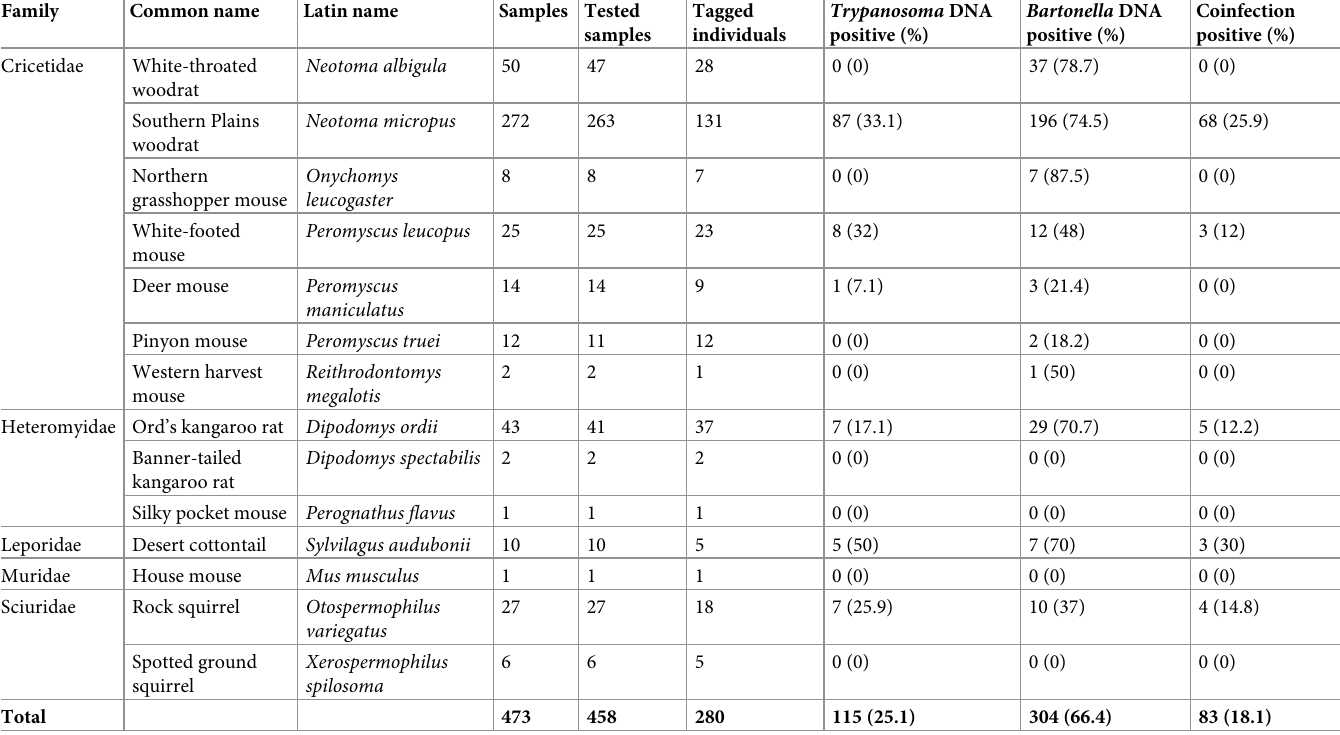
Table 1. Rodents and lagomorphs captured in the Eldorado subdivision of Santa Fe County, New Mexico, USA, from November 2002 to July